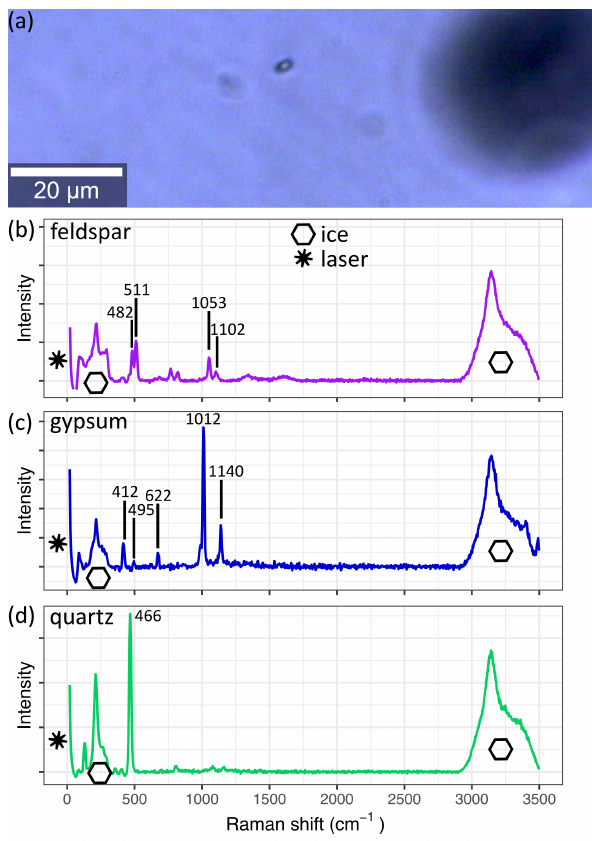
Figure 4. A micro-inclusion in S11 (1339.75m) as seen with the 20 × lens of the Raman system. The derived spectrum of the inclu- sion is shown in (b) . The spectra in (c) and (d) are from the same sample and are frequently measured throughout the core. Spectra are background corrected, and the superimposed ice and laser sig- nals are indicated. (a) The small black object is a micro-inclusion, and the larger black object out of focus is an air bubble. (b) Ob- served spectra of feldspar. (c) Observed spectra of gypsum. (d) Ob- served spectra of